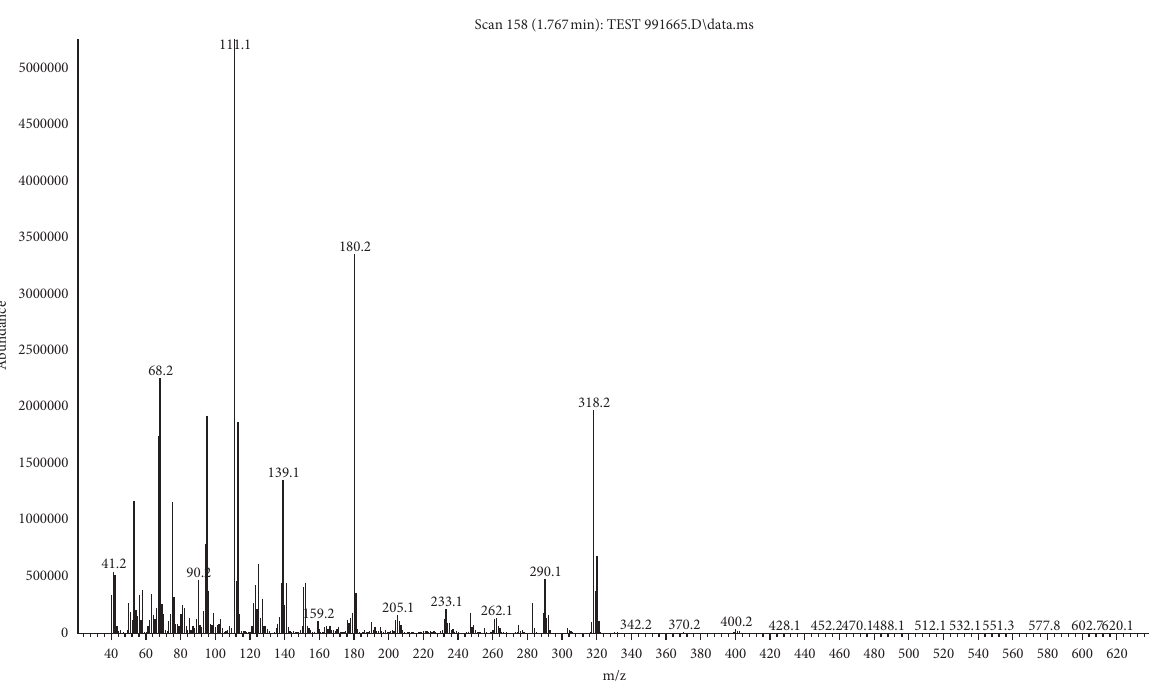
Figure 1: Mass spectrum of CPAT dye.